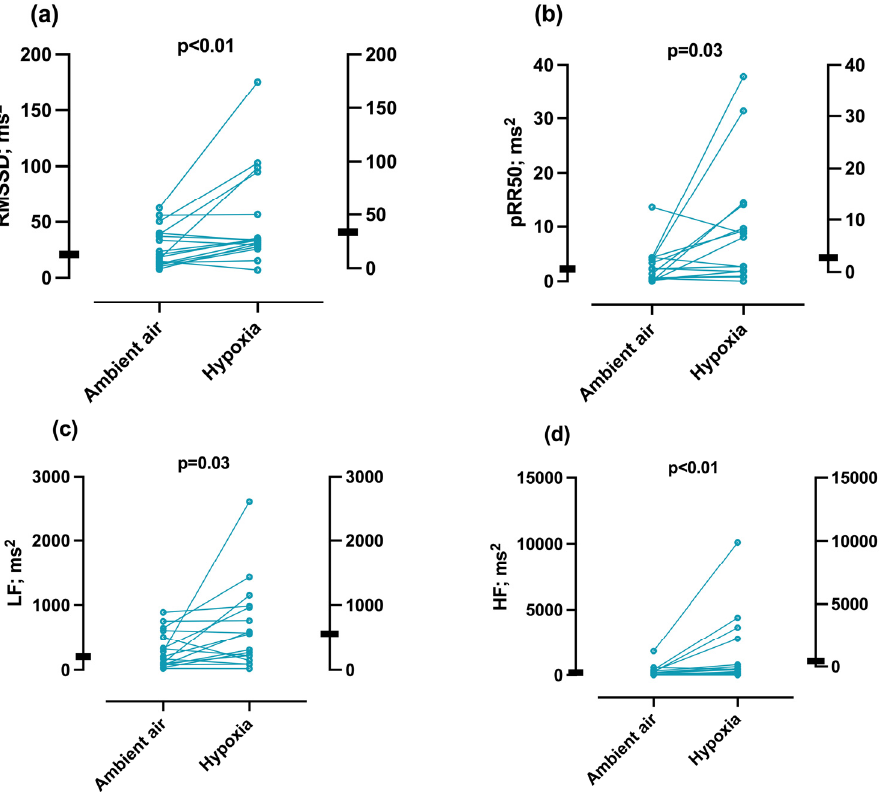
Figure 2. Difference in HRV parameters between ambient air and normobaric hypoxia. ( a ) RMSSD (ms). ( b ) pRR50 (ms). ( c ) LF (ms). ( d ) HF (ms). Each point shows a measurement of a patient. The black rectangles represent the group median. HF—high-frequency band; LF—low-frequency band; LF/HF—ratio of LF/HF; pRR50—percentage of differences higher than 50 ms in R–R intervals; RMSSD—square root of the sum of all differences between successive R–R